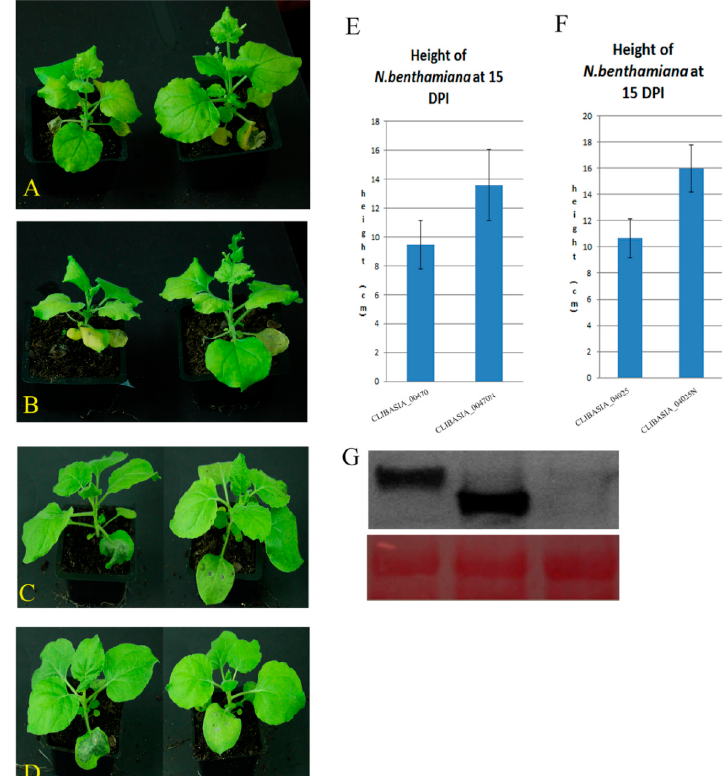
Figure 2. The four virulence factors functioned at protein level. ( A ) N. benthamiana infiltrated